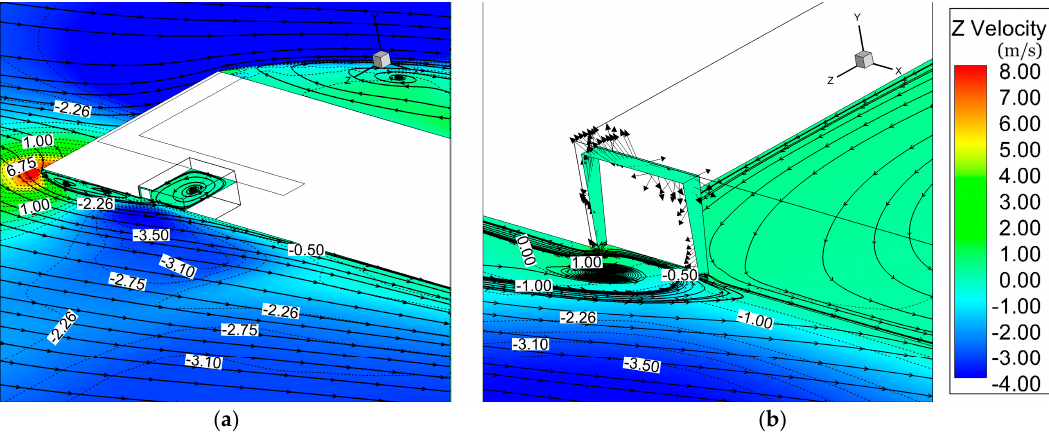
Figure 15. Flow patterns and contour of velocity (z-component) for 15 m/s wind speed and wind direction of 215 o , (a) around the building, (b) in front of the tilted window.